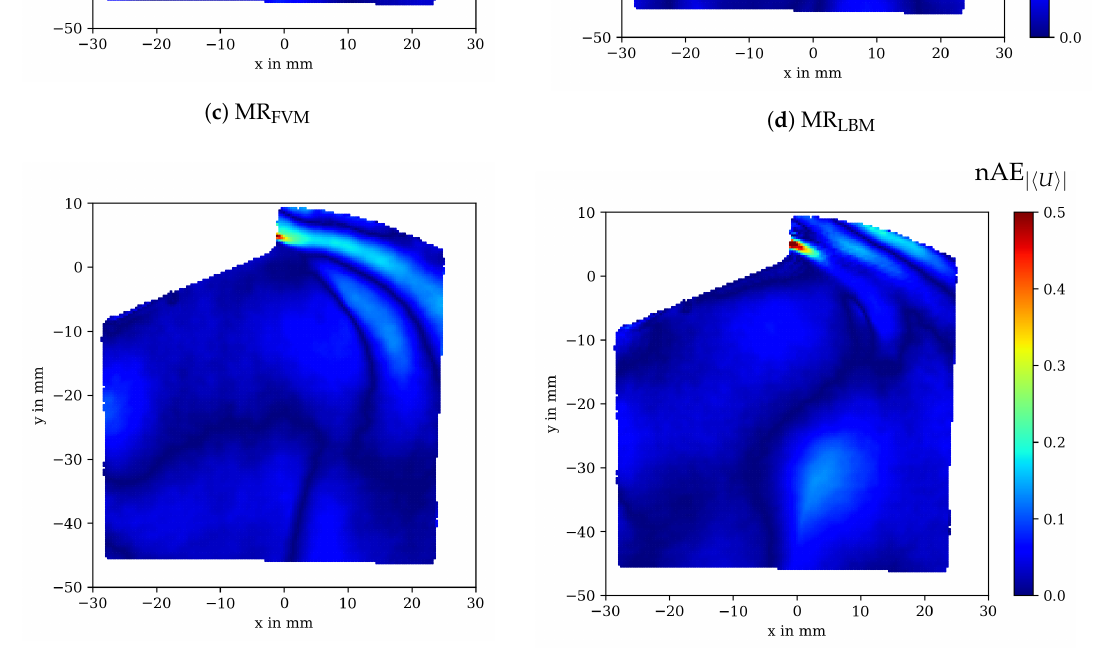
for U |(cid:104) (cid:105)|